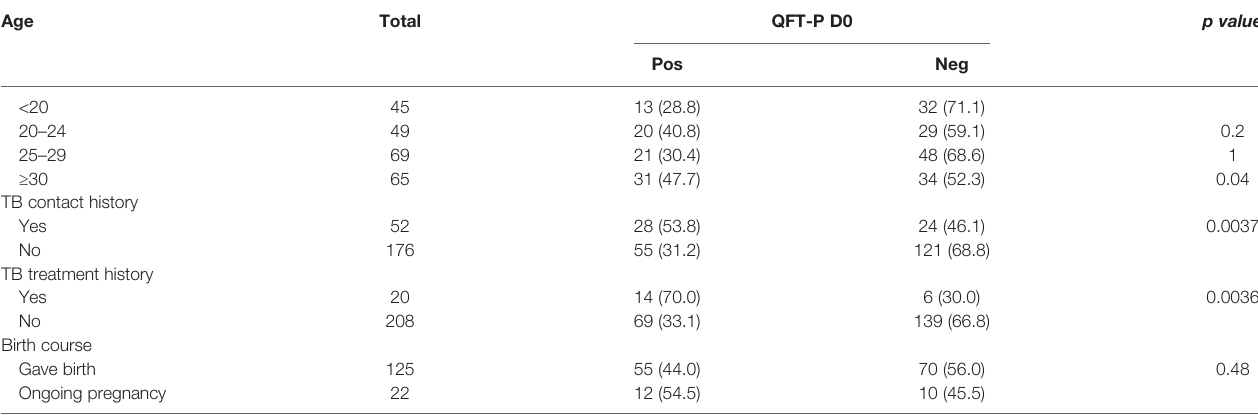
TABLE 4 | QuantiFERON TB Gold-Plus (QFT-P) assay results strati fi ed by characteristics of the pregnant women group at the inclusion (D0).